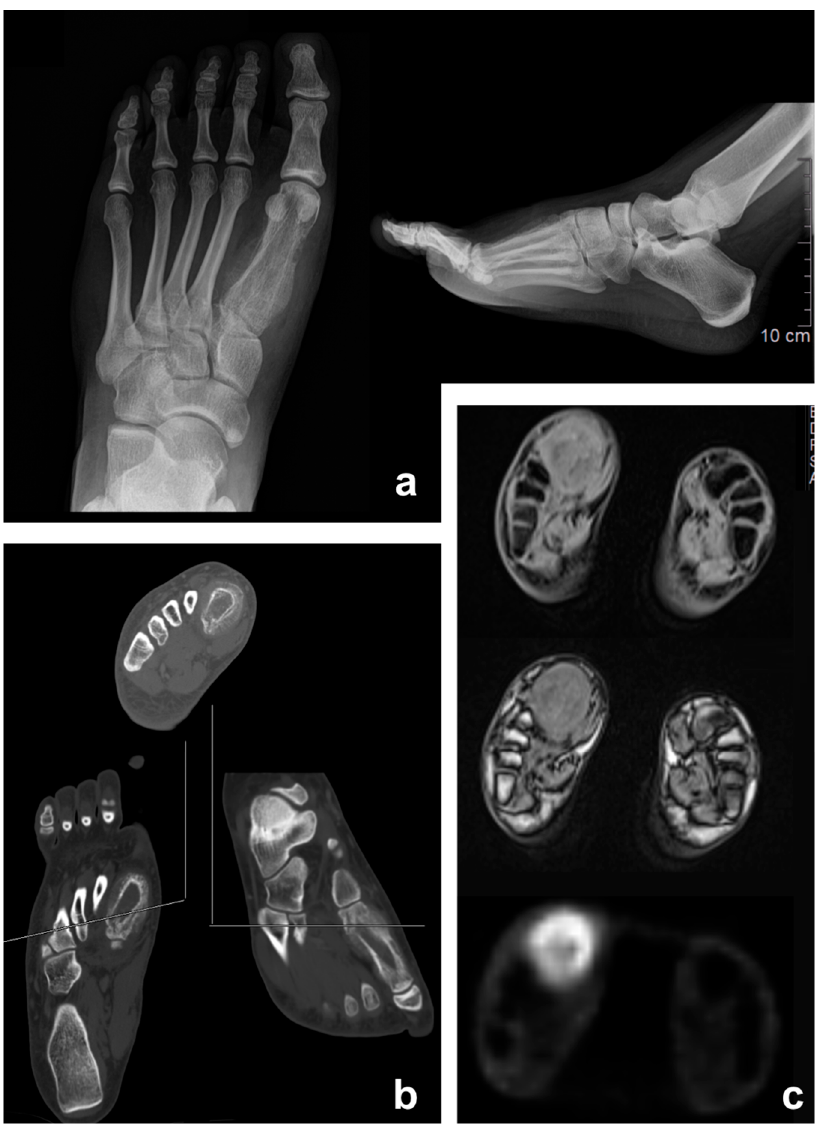
Figure 2. Ewing sarcoma of the foot (first metatarsal) in a 17-year-old female patient: Appearance on antero-posterior X-ray ( a ), CT scan ( b ), and PET/MRI ( c ).